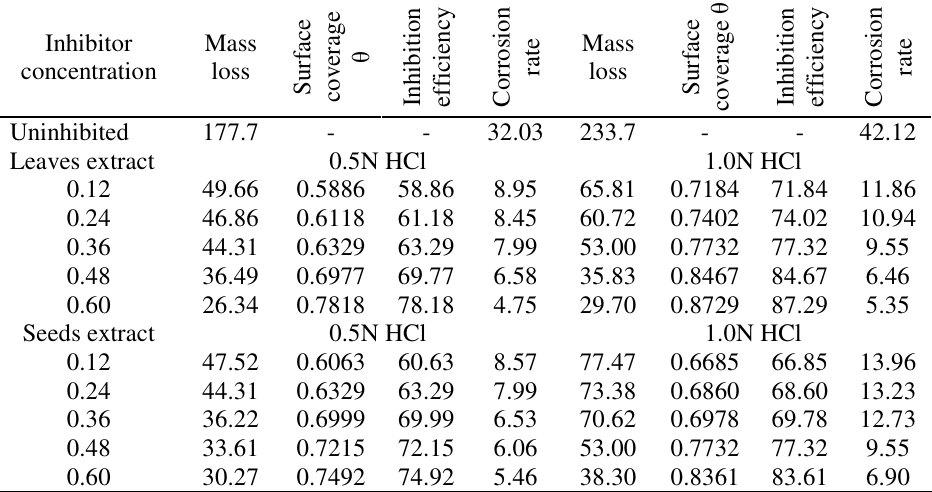
Table 2. Mass loss, surface coverage, inhibition efficiency and corrosion rate for aluminium in 0.5 N and 1.0N HCl solution with methanolic extract of Citrullus colocynthis for 24 h at 298±0.1K